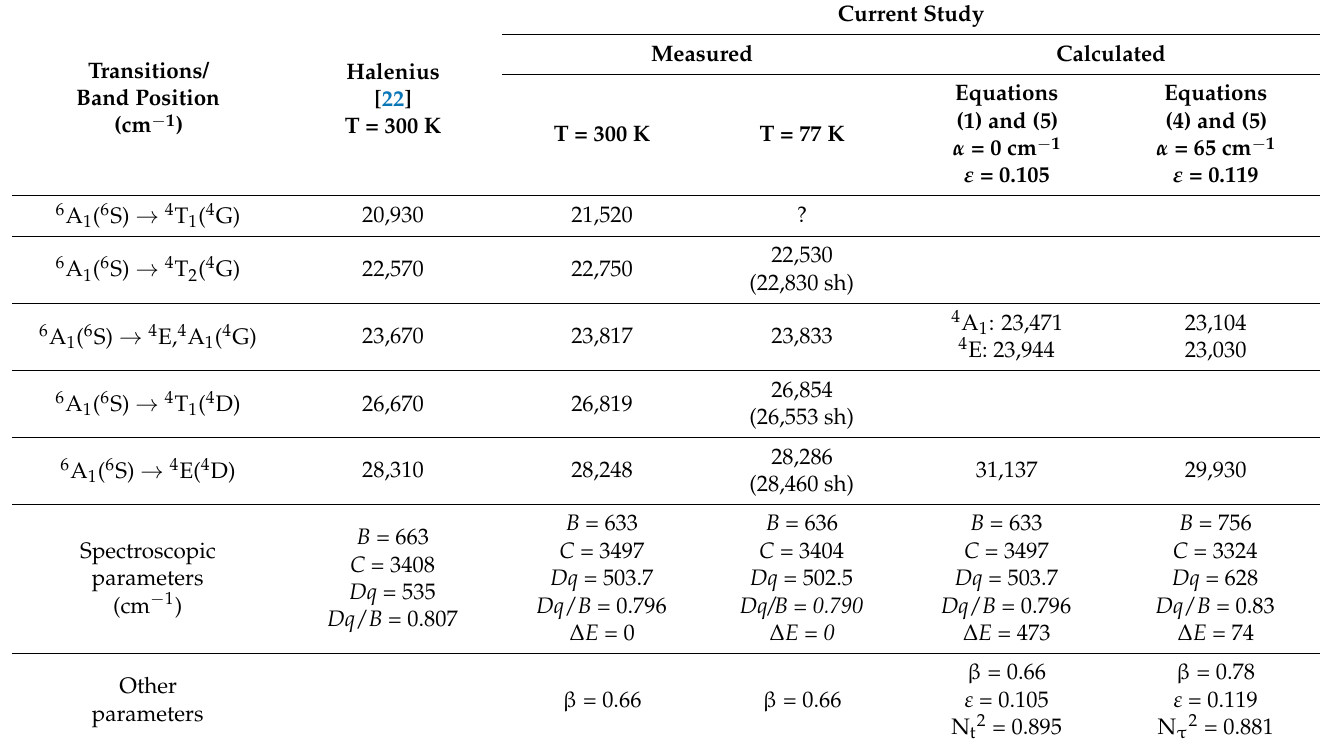
Table 8. The measured and calculated Mn 2+ -bands genthelvite G1